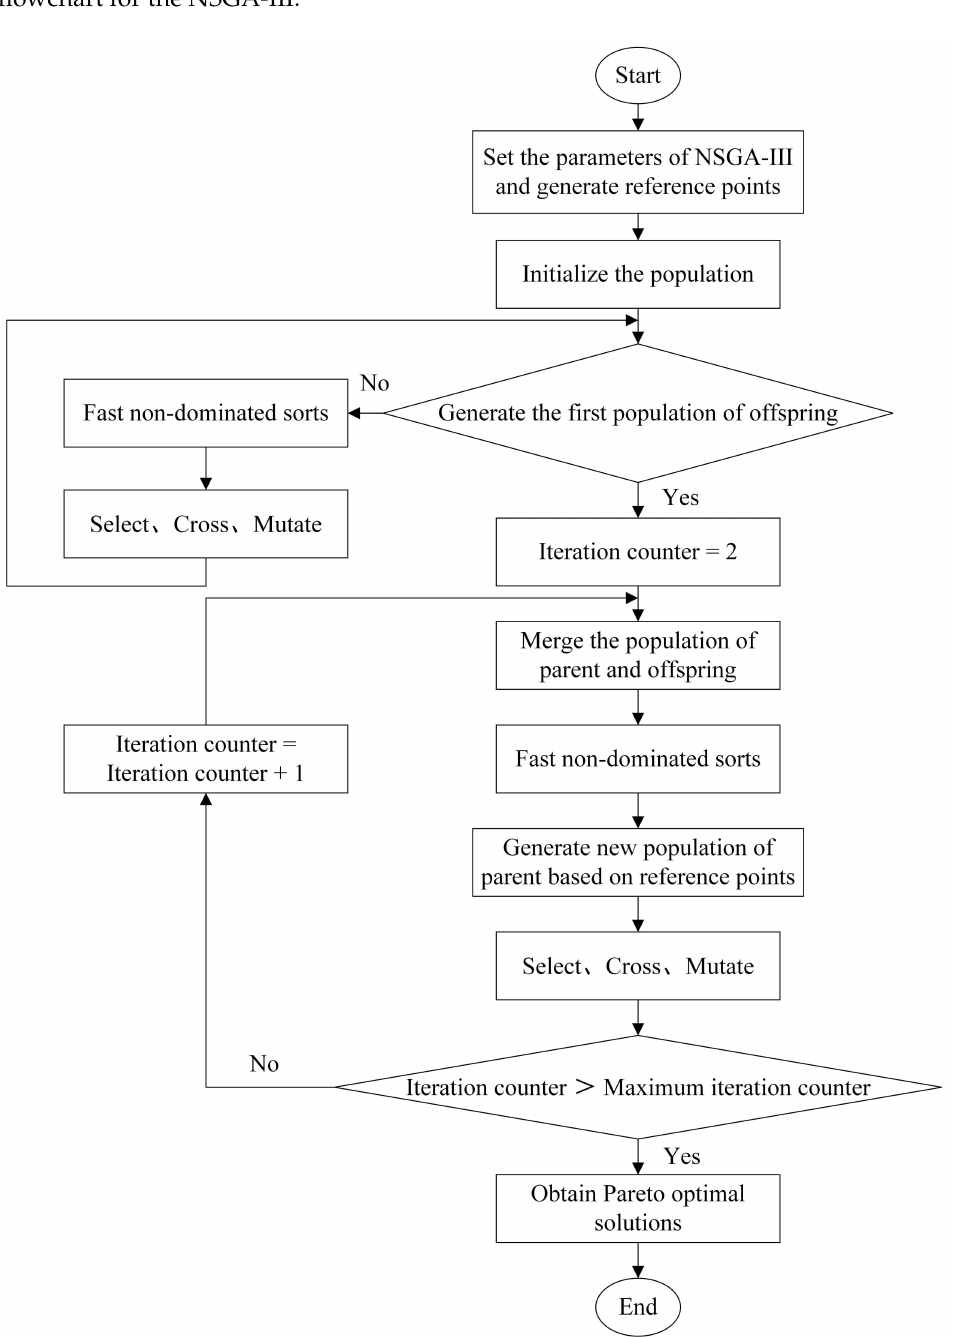
Figure 11. Flowchart of the